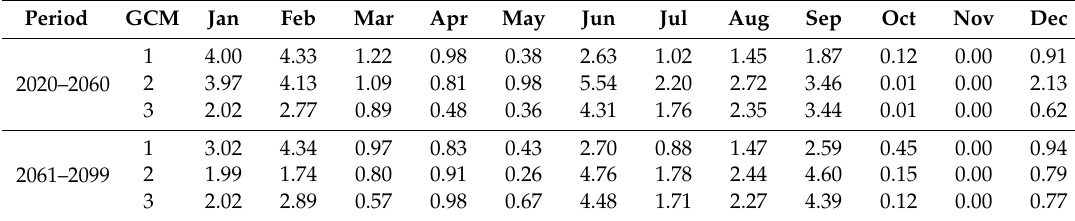
Table 14. RCP 8.5 Future Water Stress Index (WSI)